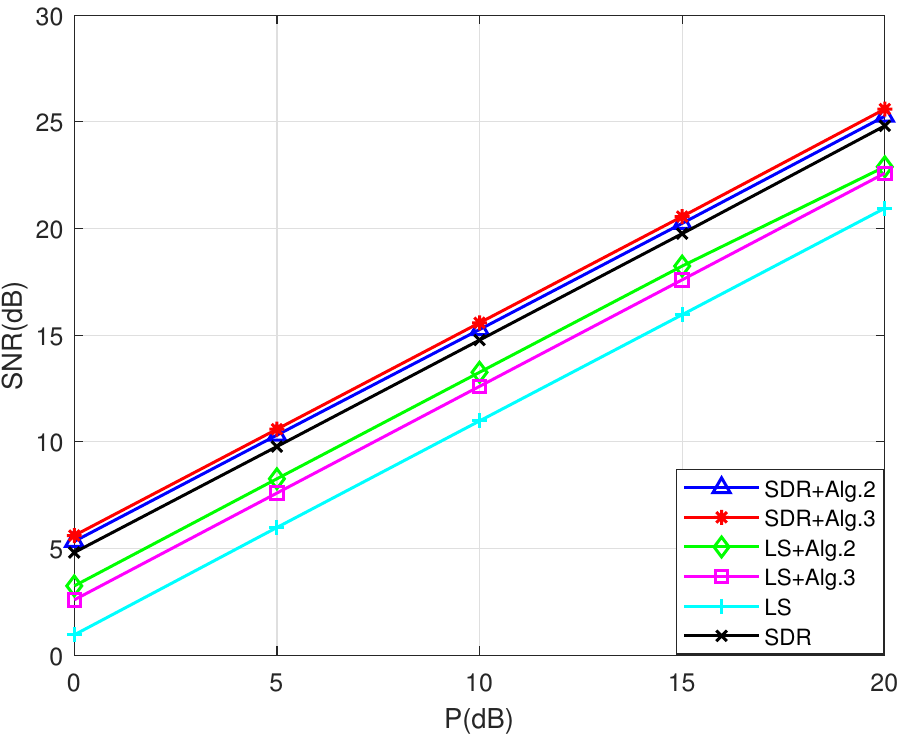
Figure 4. SINR performance comparison over the transmission power P with a small number of reflecting elements ( N = 32). Here, M = 8 and K = 4.